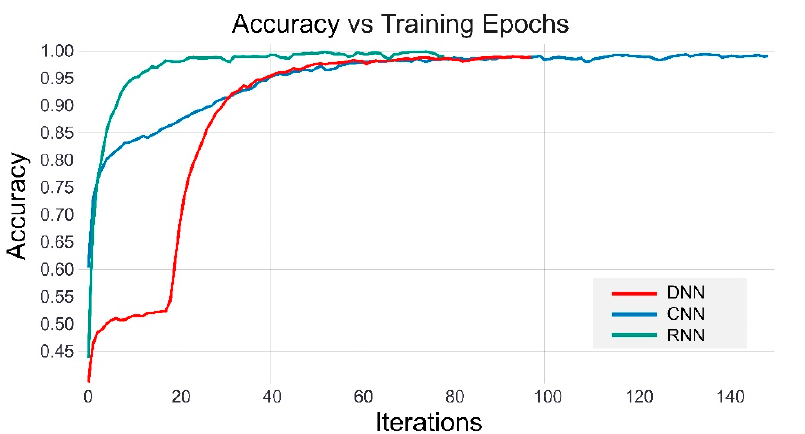
Figure 6. Plot showing the improvement in accuracy with increasing iterations during the training process for DNN (red), CNN (blue), and RNN (green). RNN was stopped early at 79 iterations and DNN was stopped at 97 iterations.